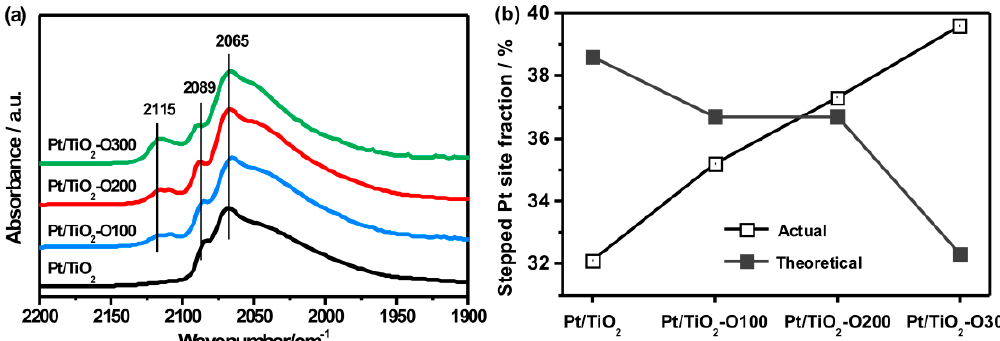
Figure 6. CO-DRIFT spectra ( a ) and stepped Pt site fraction ( b ) of various Pt / TiO 2 catalysts with di ff erent temperatures of pre-oxidation treatment. Note that the actual stepped Pt site fraction was calculated according to the equation, Fraction = I 2065 / ε , where I is the DRIFTS intensity and ε is a factor of 3.7. The theoretical stepped Pt site fraction is calculated by the Pt particle size according to the relationship observed in the literature